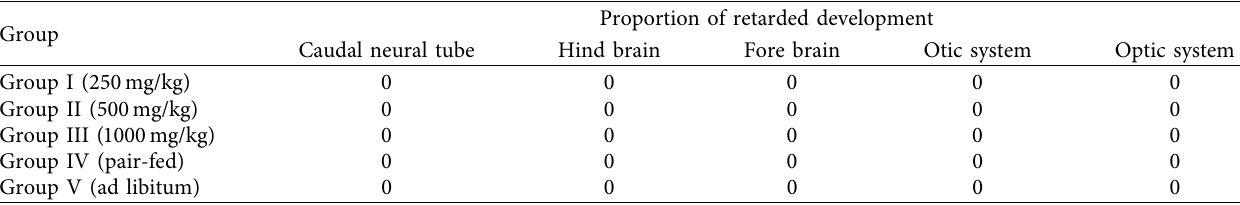
Table 3: Embryonic developmental indices of the nervous system and sense organs after treatment with the 80% ethanol fruit extract of Embelia schimperi .